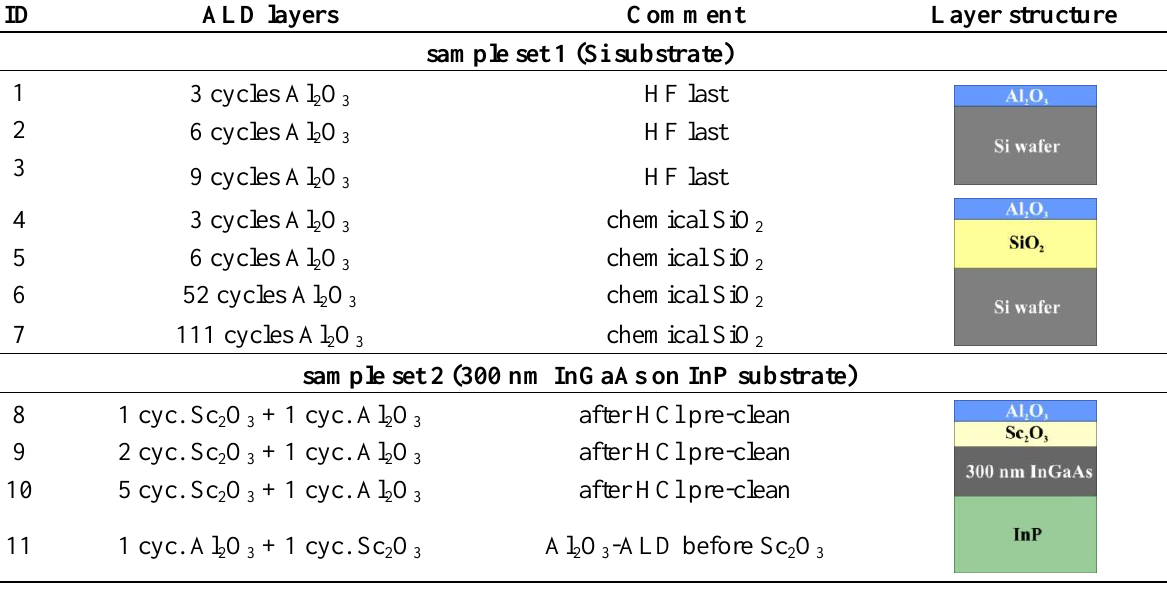
Table 1. Description of the characterized Atomic Layer Deposition (ALD)